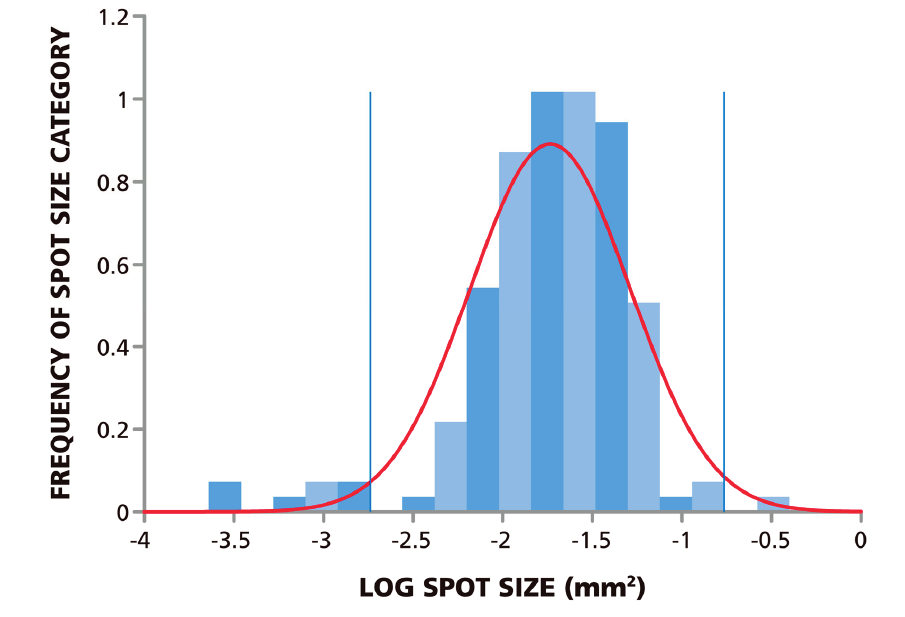
Figure 2. ELISPOT sizes on Reference Plate follow Log Normal Distribution. The experimental size distribution of 148 ELISPOTs on the Reference Plate was established by sampling replicate wells with 1.5 × 10 5 cells plated per well. The normality of the spot size distribution was tested using Kolmogorov-Smirnov goodness of fit test which resulted in a p -value of 0.146 for a target significance level of α = 0.05. The fitted Log Normal curve is overlaid in red, and the lower and upper spot size gates calculated from this curve with >99% confidence are shown by the blue